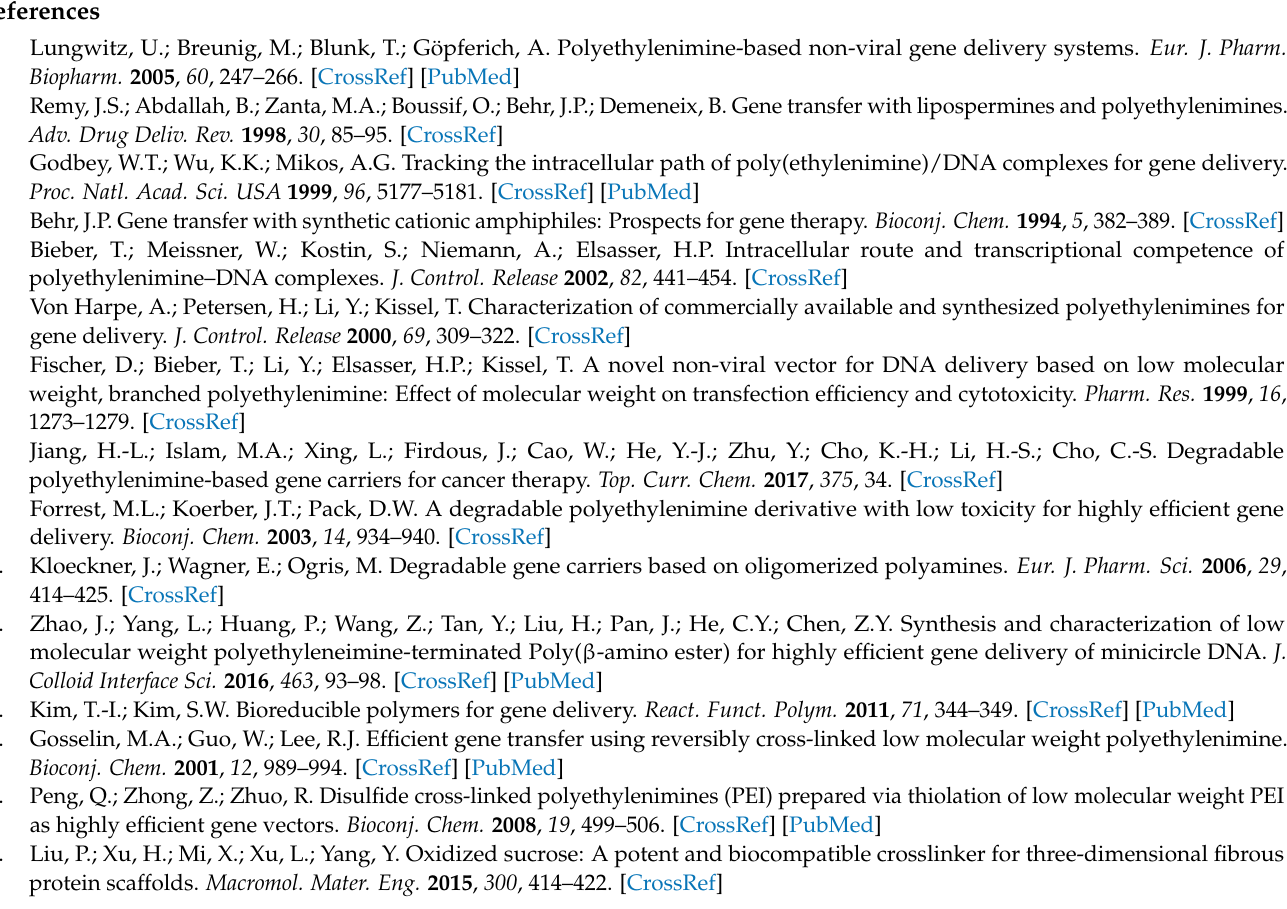
SP2K polymers; Figure S3: FTIR spectra of SP2K polymers; Figure S4: Acid–base titration of SP2K polymers; Figure S5: Protection ability of SP2K polyplexes from serum nuclease; Figure S6: Heparin competition assay of SP2K polyplexes; Figure S7: Cytotoxicity of SP2K7 and SP2K10 in ( A ) A549 cells and ( B ) RAW264.7 cells; Figure S8: Osmolality of SP2K polymers; Table S1: Average PDI values of SP2K polyplexes ( n =